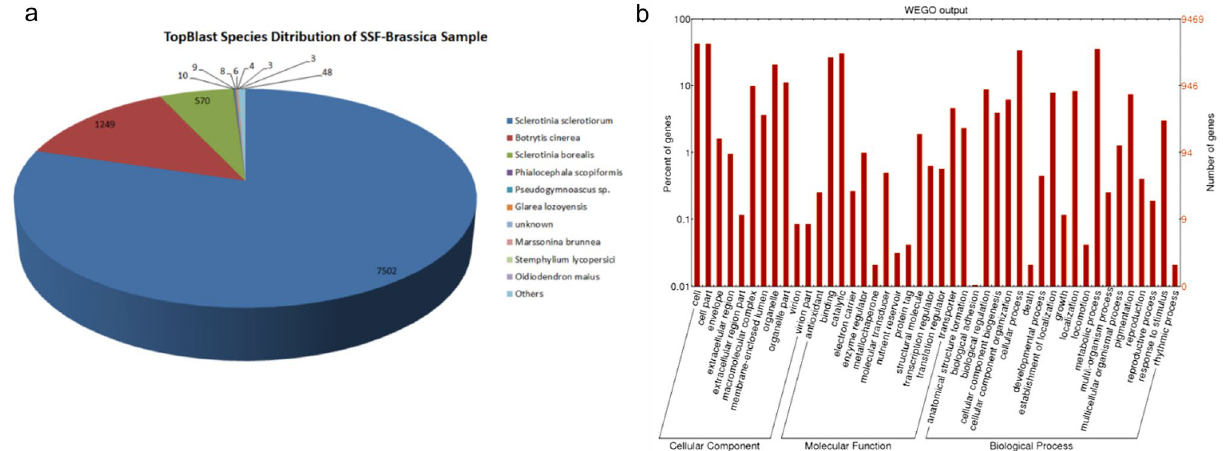
Figure 2. Genome sequence feature of the S. sclerotiorum ‘ESR-01’ isolate. ( a ) Top Blast Species distribution chart and ( b ) WEGO plot for the GO term distribution of the genes predicted in whole-genome sequences of ‘ESR-01’ isolate into biological process, cellular component, and molecular